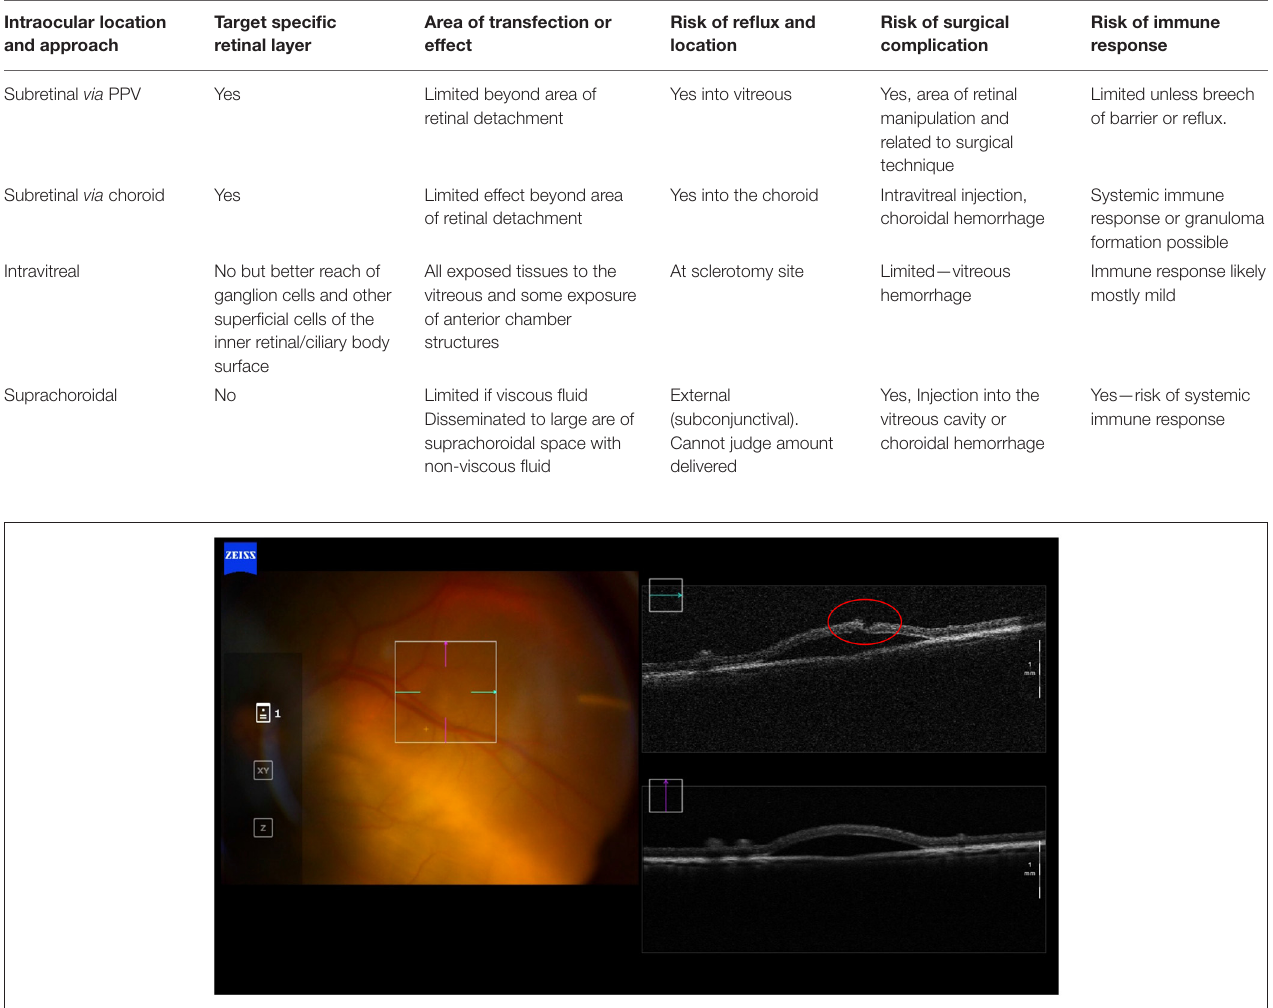
FIGURE 2 | Transvitreal subretinal injection without pars plana vitrectomy. Intraoperative OCT picture showing absence of reflux after the subretinal injection in a non-vitrectomized living porcine eye. Intact vitreous may act as a plug and prevent reflux into the vitreous body, as we have observed in these subretinal injections experiments carried out in live